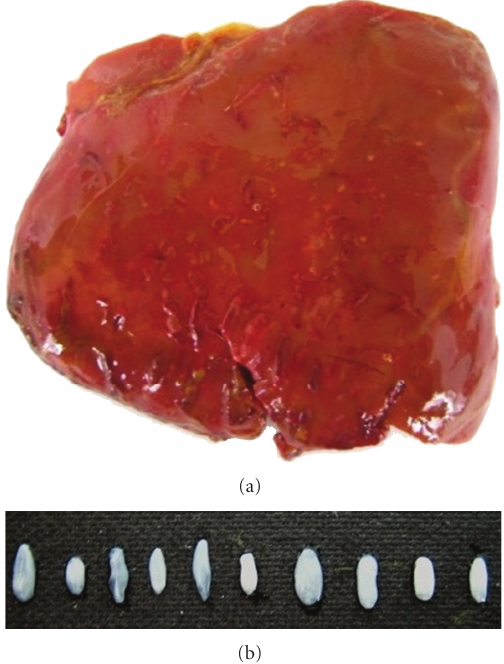
Figure 1: Liver of one-month-old dead goat with haemorrhagic tracts (a) and ten recovered cystic samples (b).